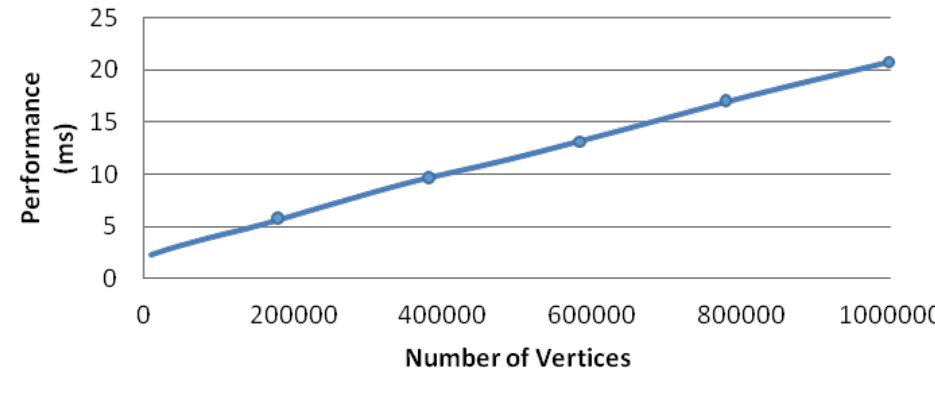
Figure 9. The performance of grid-mesh layouts. The X -axis is the number of vertices, and the Y -axis is the performance time. The average P of each cluster is 9, based on the solar merger